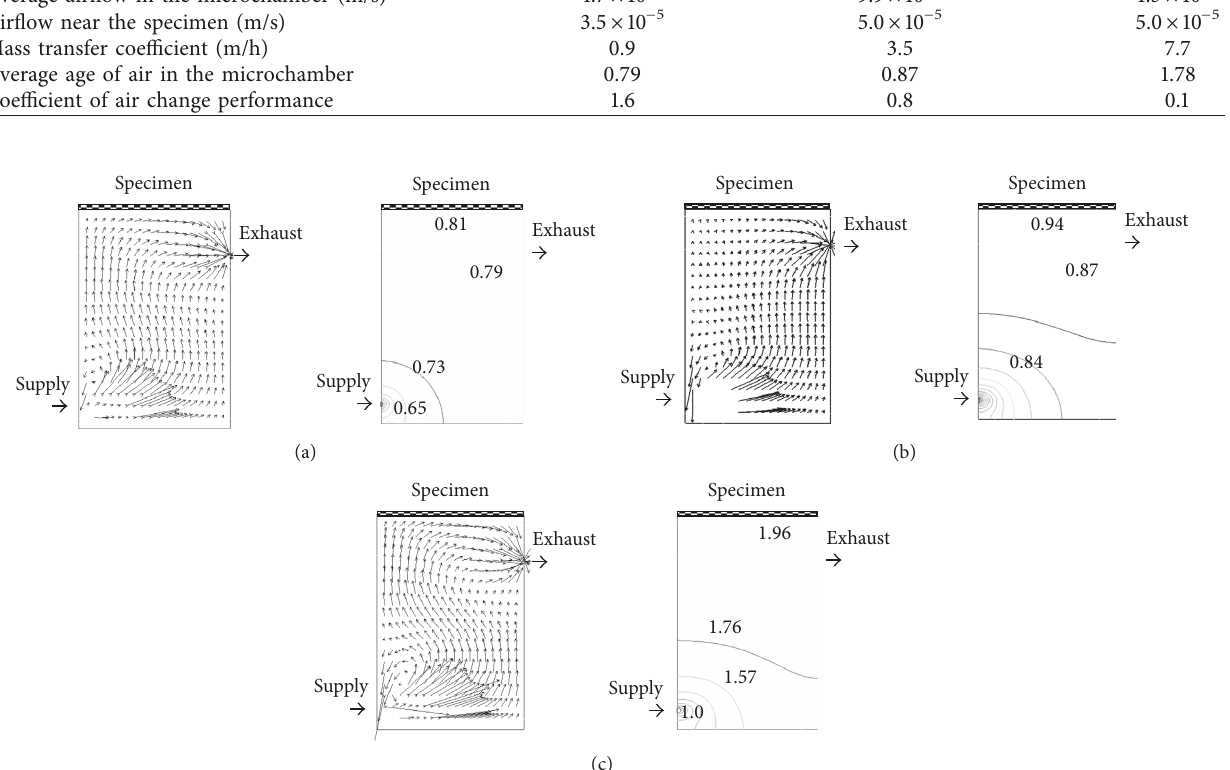
Figure 7: Distribution of airflow vectors and air ages: (a) air change rate of 0.8times/h, (b) air change rate of 1.5times/h, and (c) air change rate of 4.0